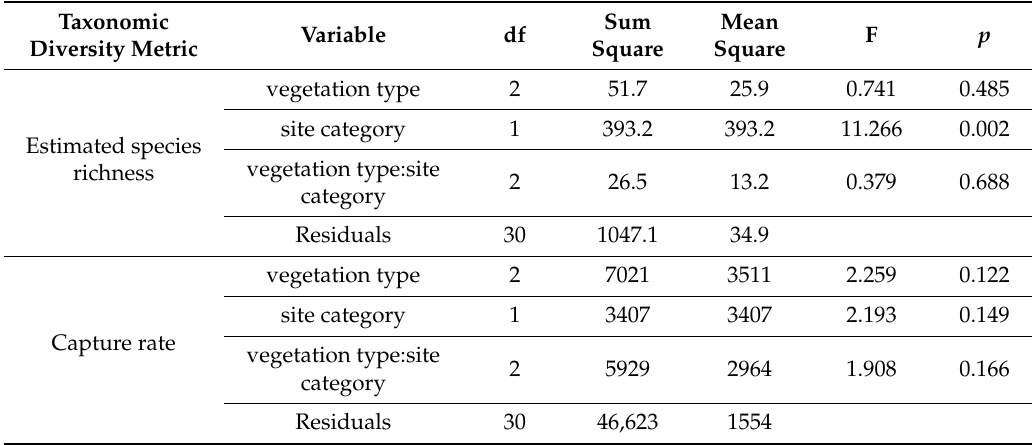
Table 4. Analysis of variance for estimated richness (Jackknife 1) and capture